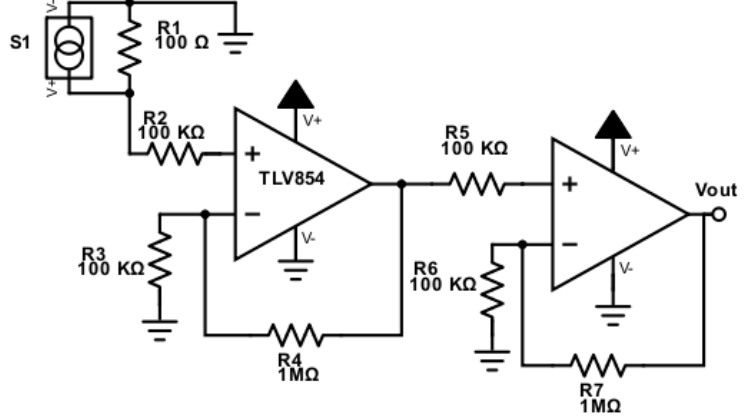
Figure 3. Schematic of the amplification circuit.